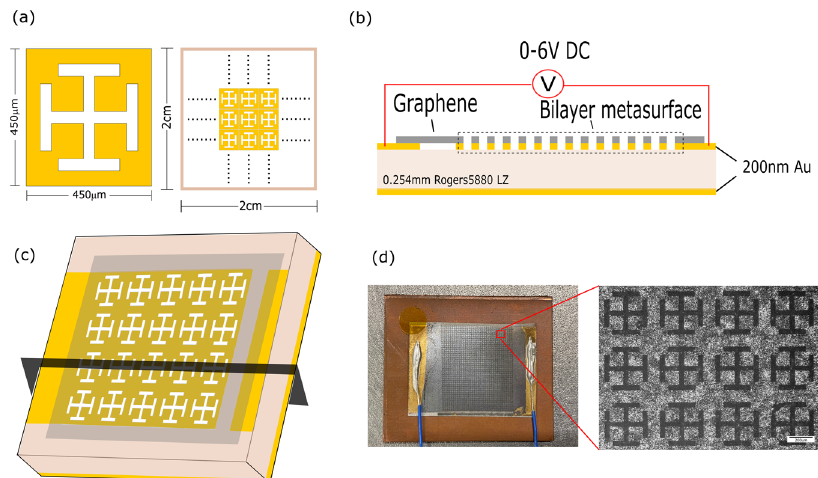
Fig. 1 Summary of the graphene/gold bilayer metasurface incorporated into a 0.2 THz frequency-selective absorber. a Jerusalem-cross-slot unit cell dimensions and array structure. b Cross section of the graphene/gold bilayer superimposed metasurface structure indicated from the intersecting black plane in ( c ). c Schematic of the 0.2 THz frequency-selective absorber device. d Fabricated bilayer device with an enlarged optical image showing well- de fi ned metasurface